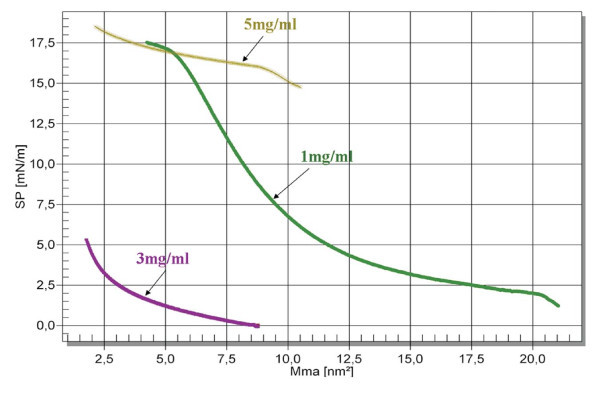
Surface pressure versus molecular area isotherms obtained by 1, 3, 5 mg/ml chloroform solutions of PnBuA-b-PAA.